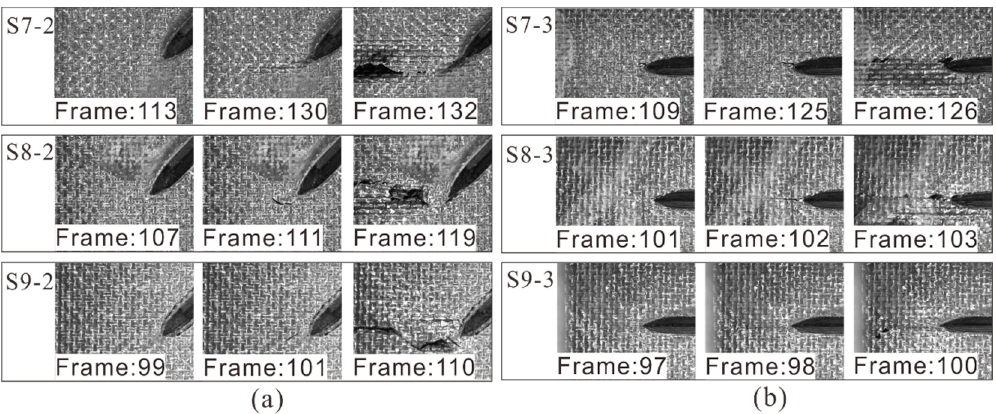
Figure 13. ( a ) 45° and ( b ) 90° deep cracks propagation under compression. Figure 13. ( a ) 45 ◦ and ( b ) 90 ◦ deep cracks propagation under compression.